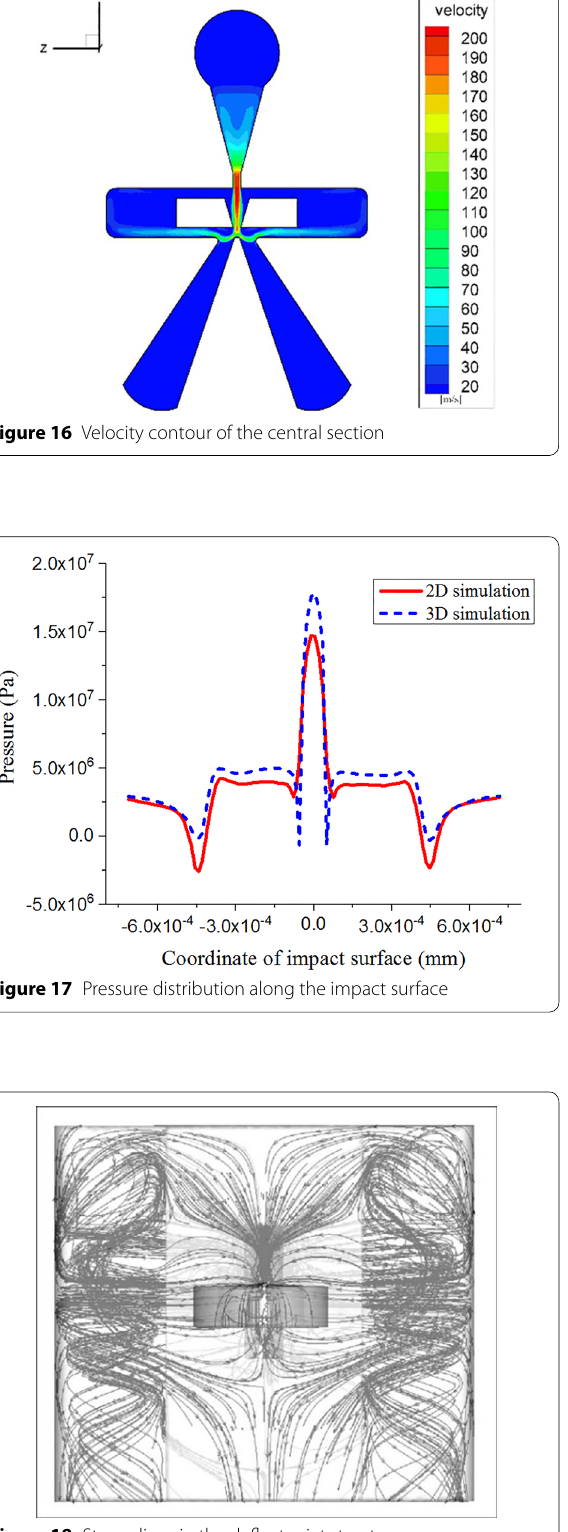
Figure 18 Streamlines in the deflector jet structure